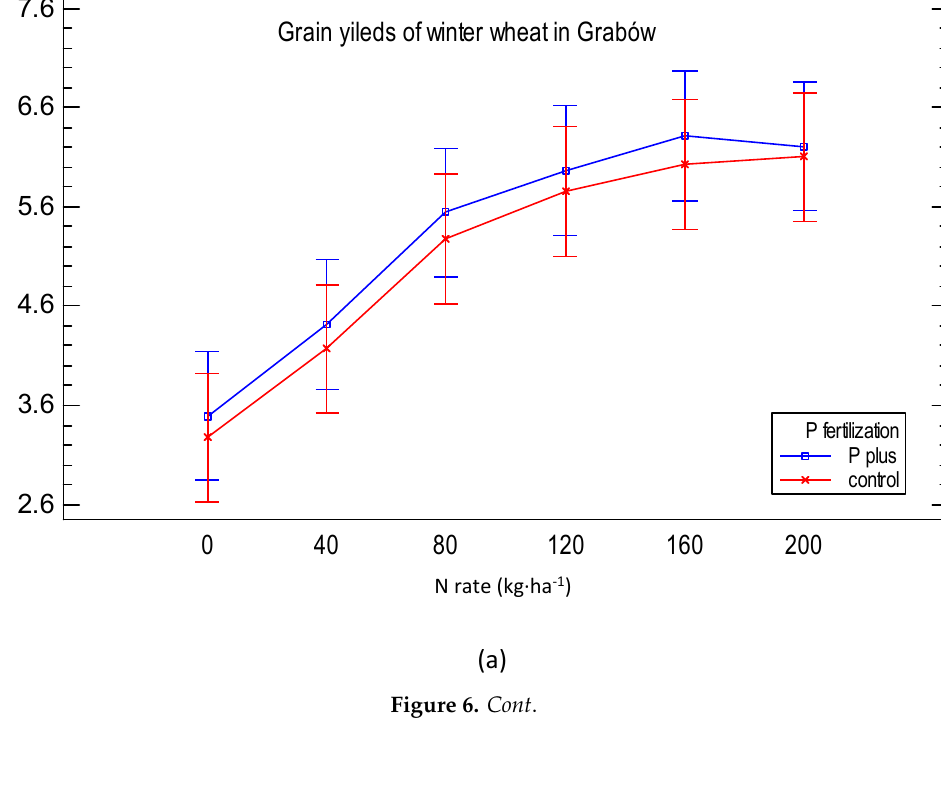
(b) Figure 6. Grain yields of winter wheat at increasing additions of N fertilizer at the P-plus and control levels of P; 95% Tukey HSD intervals; n = 384 for each location; (P fertilization ( a ) Grabów HSD 0.550, ( b ) Baborówko HSD